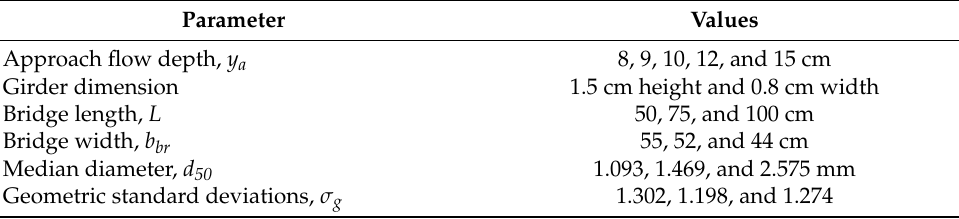
Table 2. Values of experimental